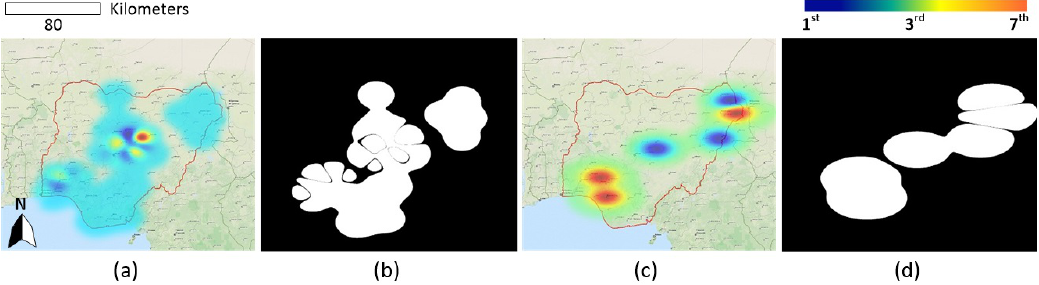
Figure 8. An example of the comparison between the prediction map and the reality map: ( a ) the map interpolated by the inferred spatial and temporal data; ( b ) the filtering mask of ( a ); ( c ) the map generated from the subsequent realistic spatial and temporal data; ( d ) the filtering mask of ( c